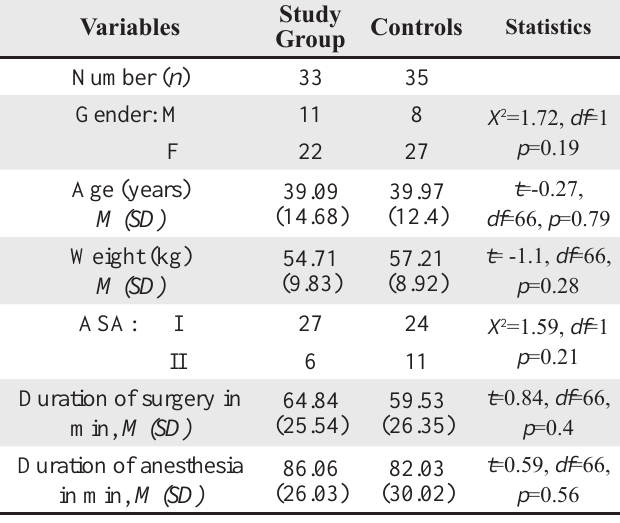
Table 2 : Patient characteristics